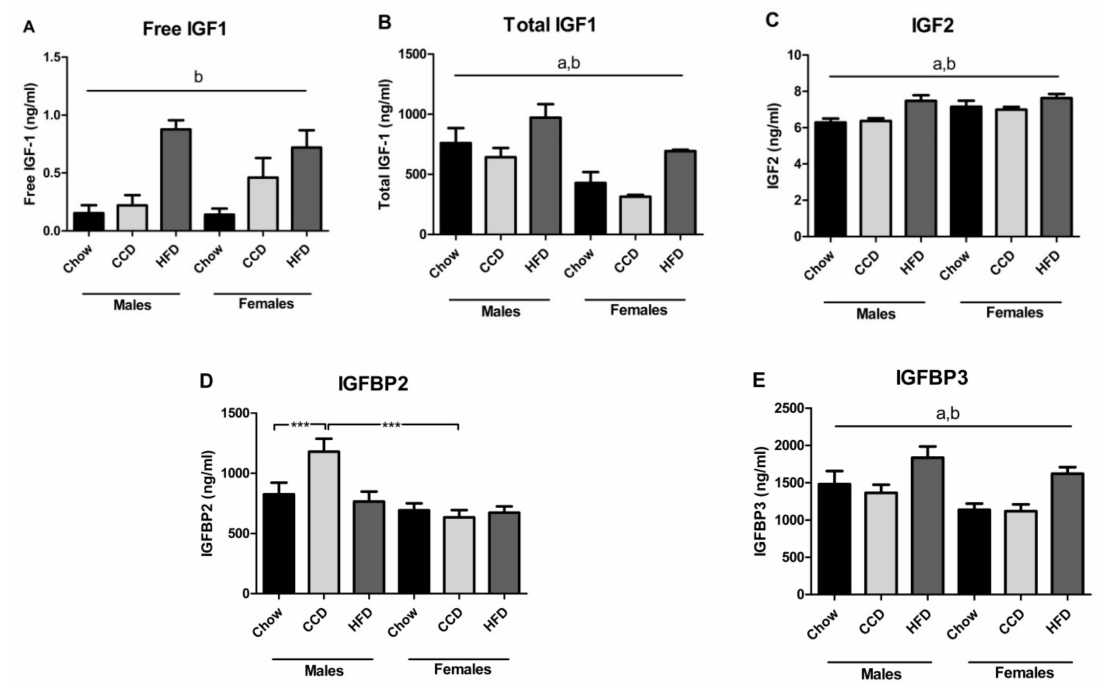
Figure 3. Circulating levels of free IGF-1 ( A ), total IGF-1 ( B ), IGF2 ( C ), IGFBP2 ( D ) and IGFBP3 ( E ) in mice on a high-fat diet (HFD), commercial control diet (CCD) or chow diet for 8 weeks. *** p < 0.001, a: e ff ect of sex, b: e ff ect of diet, n =